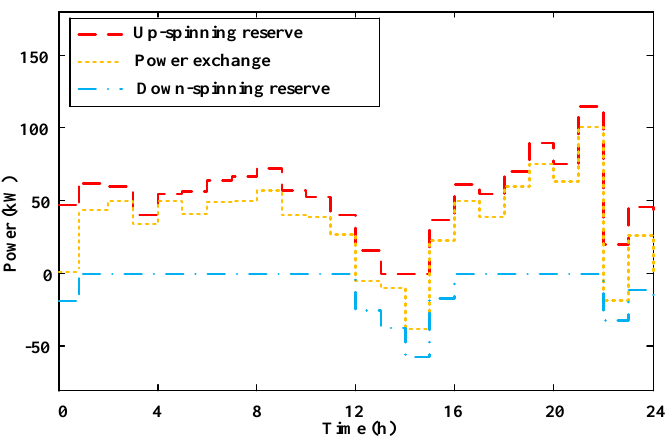
Figure 7. Optimization results of system daily up-spinning spinning reserve, down-spinning reserve, and power exchange curves (for α = 0.5, and a renewable energy penetration rate of 30%).